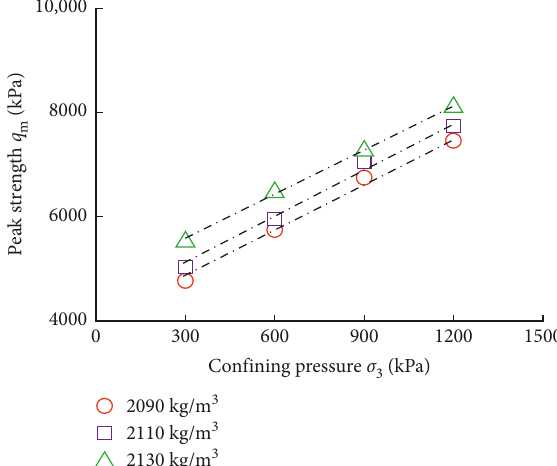
Figure 7: Relation between peak strength and confining pressure under different aggregate